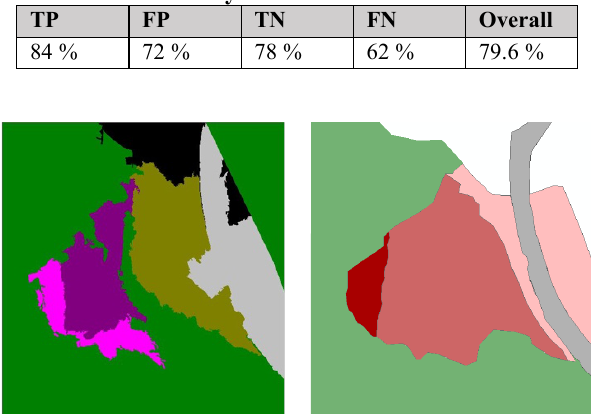
Table 2. Accuracy statistics of OBIA evaluation